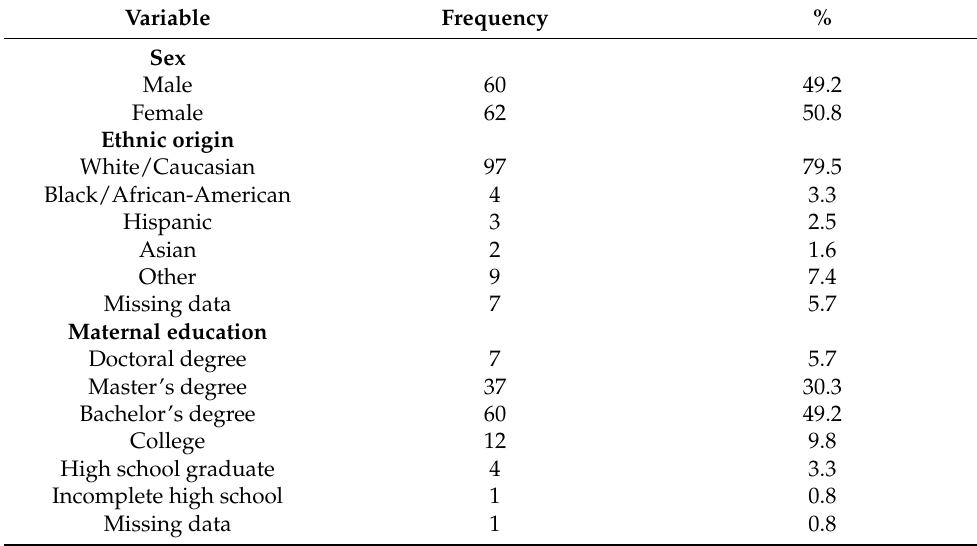
Table 1. Demographic characteristics of study